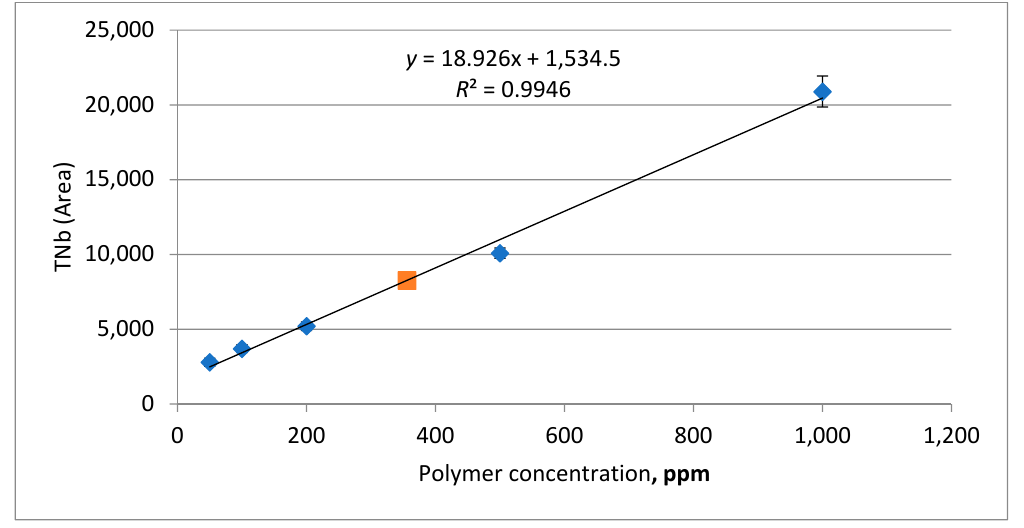
Figure 5. Electrochemical detector signal vs polymer A concentration, graduation dependence.